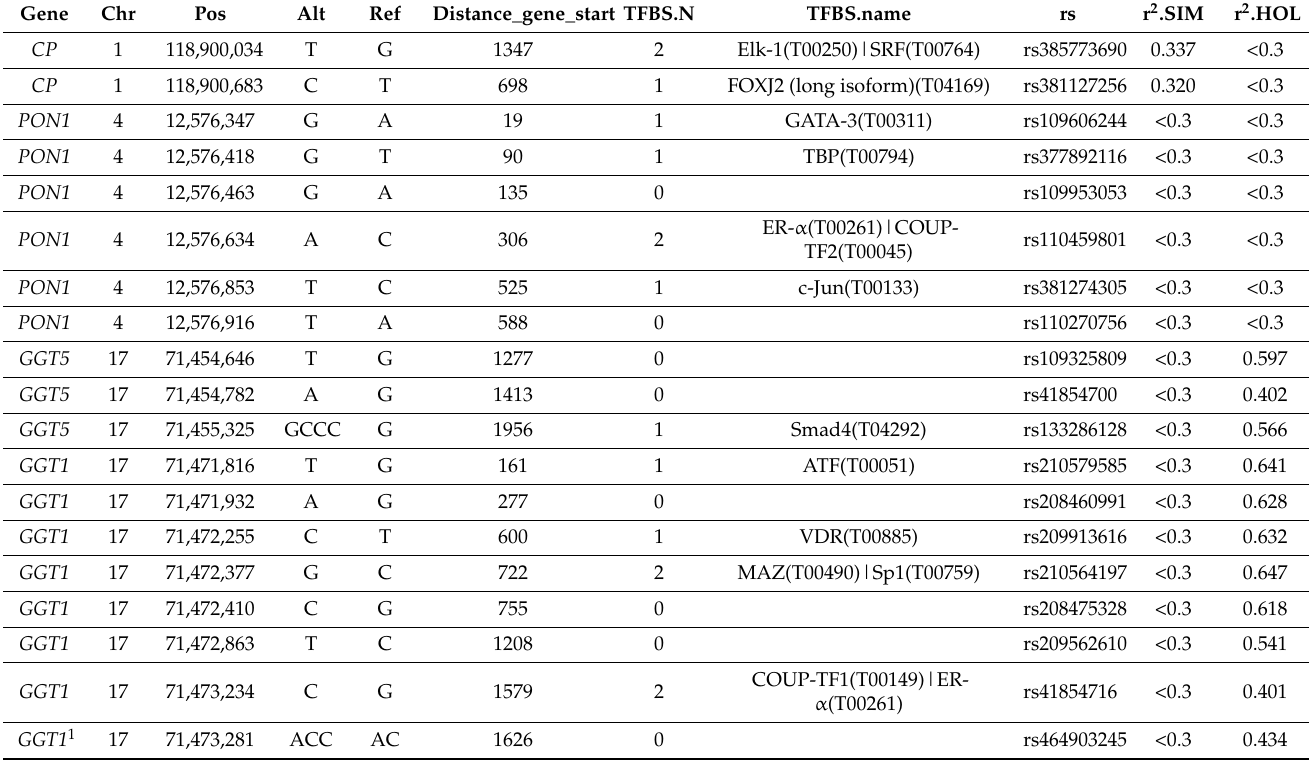
Table 2. Candidate causative variants showing r 2 > 0.2 with high-significance